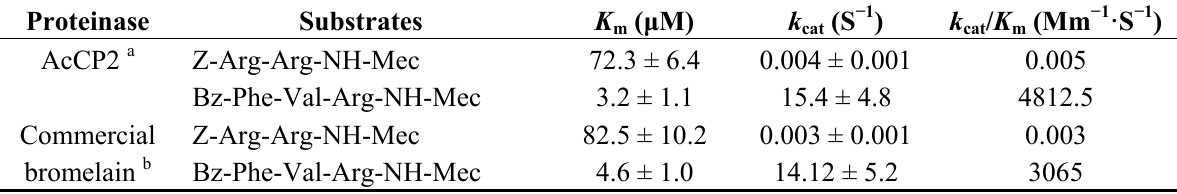
Table 1. Michaelis-Menten constants ( K the mean values of three replicates ± SE ( n =